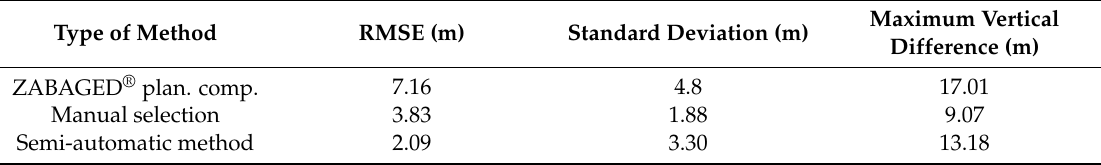
Table 3. Basic parameters of 3D rock object layout, ZABAGED ® planimetric components,